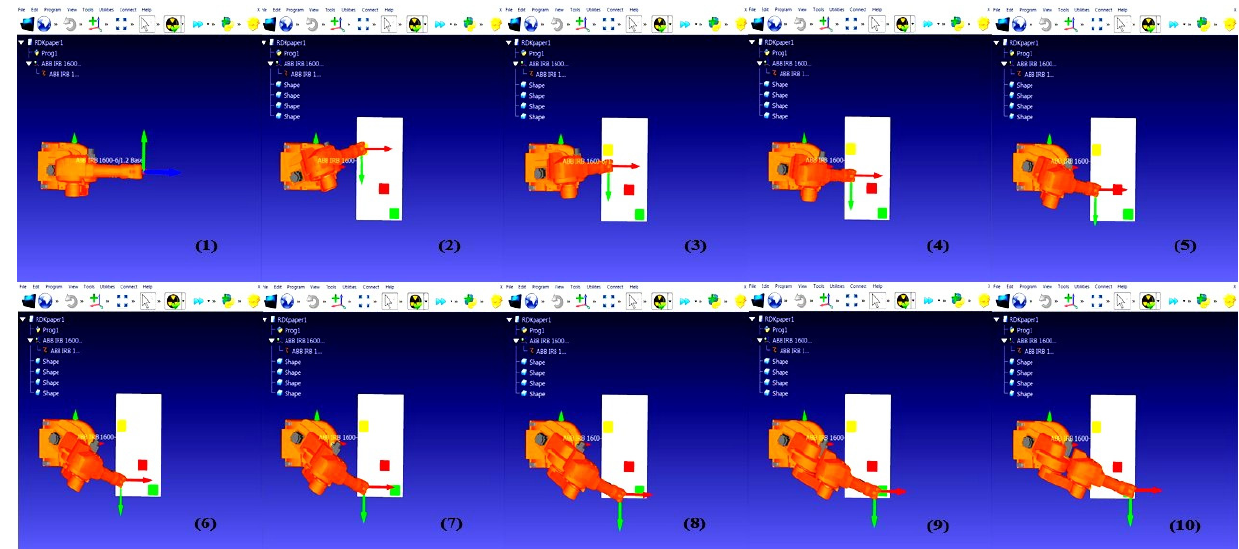
Figure 6. Simulation results: ( 1 ) Initial position of end-effector before starting the process. ( 2 ) The robot starts moving from the start point in yellow. ( 3 ) The robot moves down. ( 4 ) The robot moves down again. ( 5 ) The robot moves down again. ( 6 ) The robot moves down again. ( 7 ) The robot moves down again. ( 8 ) The robot moves right. ( 9 ) The robot moves right again. ( 10 ) The robot moves right and reaches the target in green.